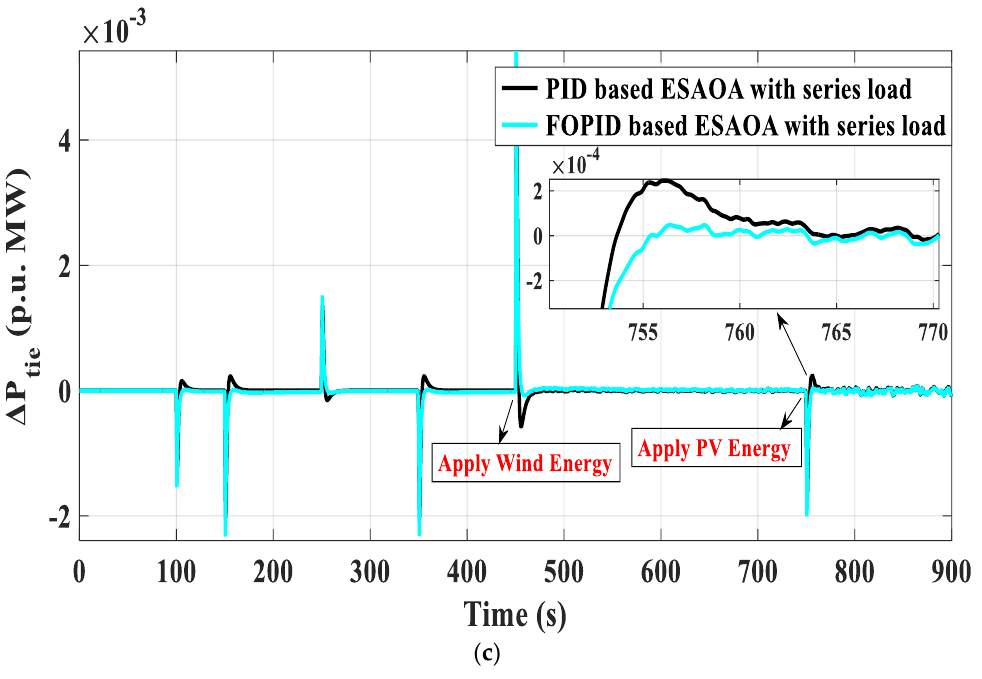
Figure 20. Dynamic system response of scenario B with series SLP at area-1, wind energy at t = 450 s at area-1, and PV at t = 750 s at area-2 ( a ) ∆𝑓 1 , ( b ) ∆𝑓 2 , and ( c ) ∆𝑝 𝑡𝑖𝑒 .